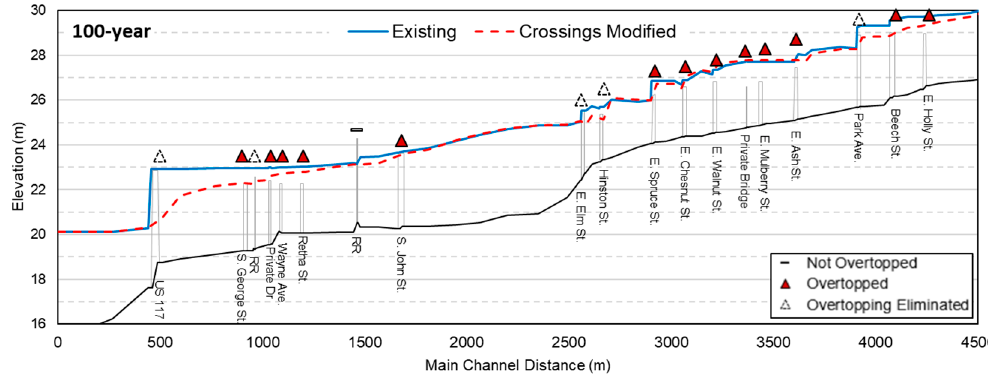
Figure 5. Water surface profiles for the Existing Condition and the Crossings Modified scenario for the 100- year event.